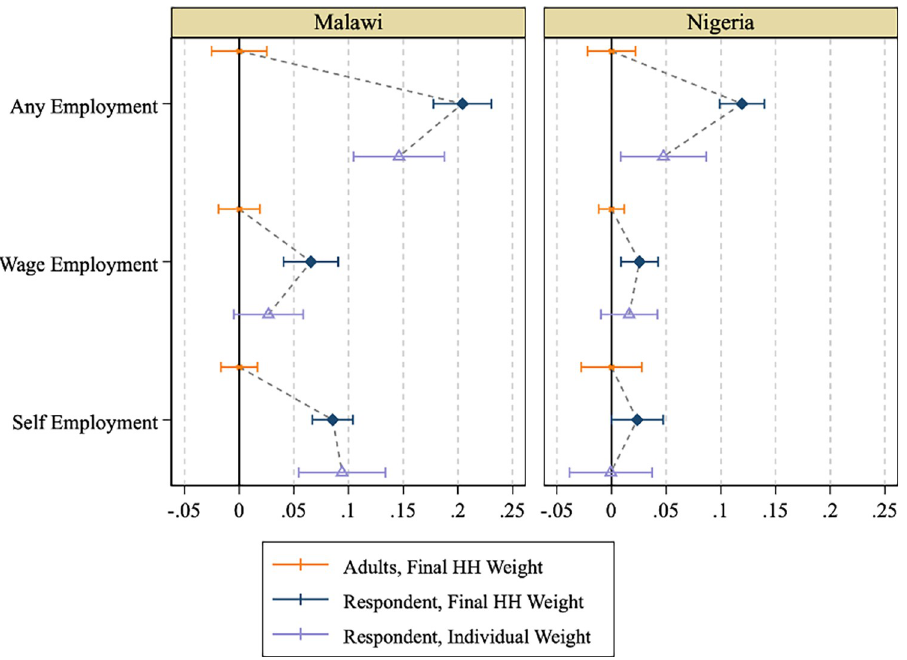
Fig 5. HFPS round 5 employment outcomes, with HFPS household versus individual weights.